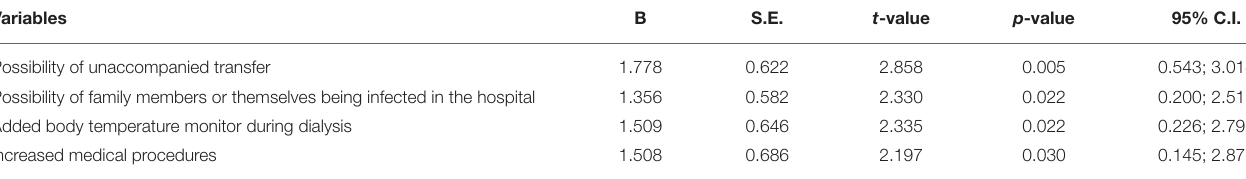
TABLE 4 | Multiple linear regression analysis of factors independently predictive of elevated anxiety symptoms during the early COVID-19 pandemic. Variables B S.E. t -value p -value 95%